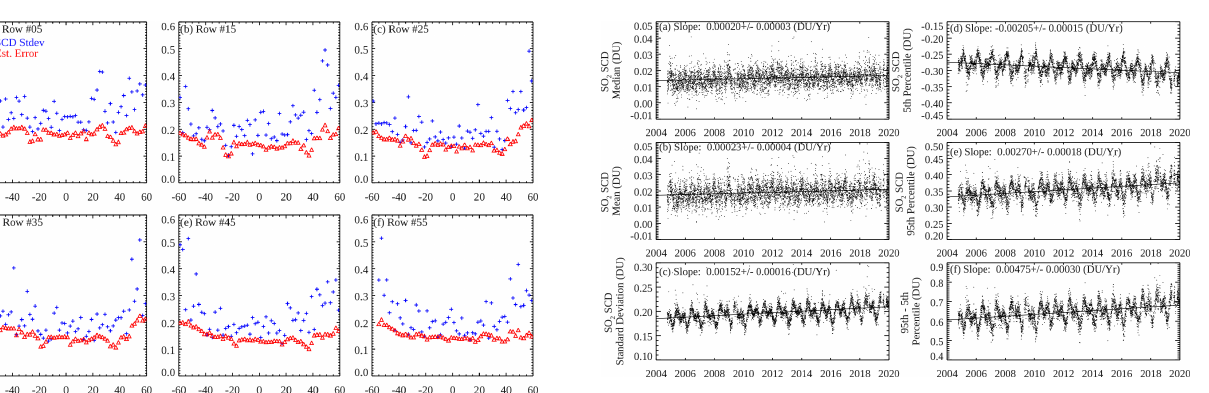
Figure 4. Daily (a) median, (b) mean, (c) standard deviation, (d) 5th percentile, (e) 95th percentile, and (f) the difference between 5th and 95th percentiles of OMI SO 2 SCDs over the equatorial east Pa- cific (20 ◦ S–20 ◦ N, 130–150 ◦ W) during the period of 2004–2019 indicate stable long-term performance of the PCA-based anthro- pogenic SO 2 algorithm. Estimated linear trends and their 95% con- fidence intervals are given for each time series. Only rows deemed to be minimally affected by the row anomaly are included in the statistical analysis. Days with possible influence of large volcanic SO 2 eruptions have also been